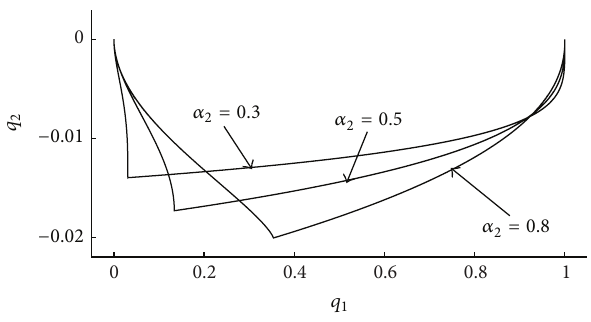
Figure 20: The phase trajectories in optimal control mode for Riemann-Liouville and Caputo double integrator in case of 𝛼 1 = 1